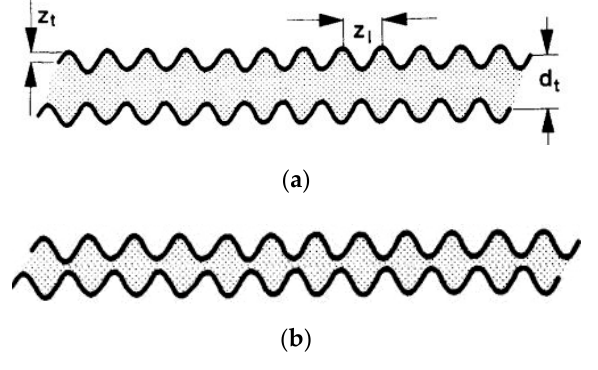
Figure 3. Schematic of geometric dynamic recrystallization (GDRX): ( a ) serrated boundary shape; ( b ) formation of new equiaxed grains due to mutual bulge.